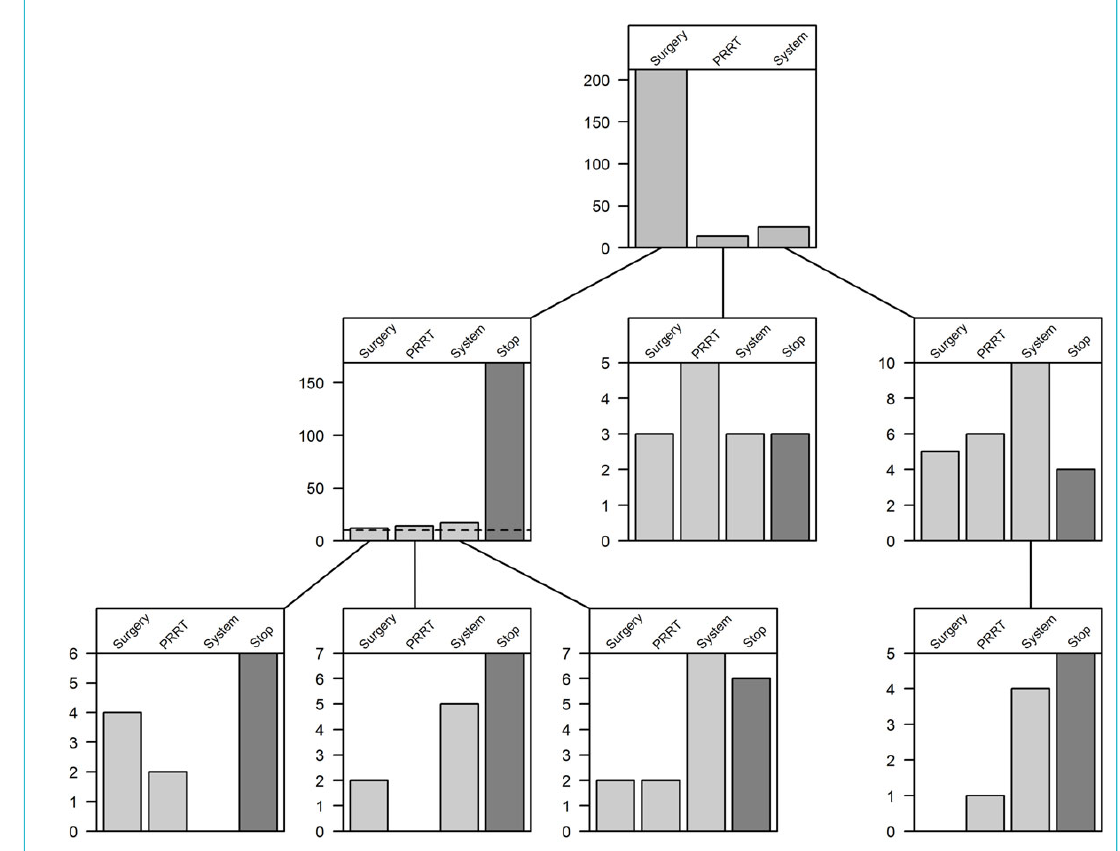
Figure 2: Tree plot for pancreatic neuroendocrine tumours based on the secondary analysis set.Each row represents a therapy line. Stop indi- cates that no more treatments were documented. (n = 251 patients). PPRT = peptide receptor radionuclide